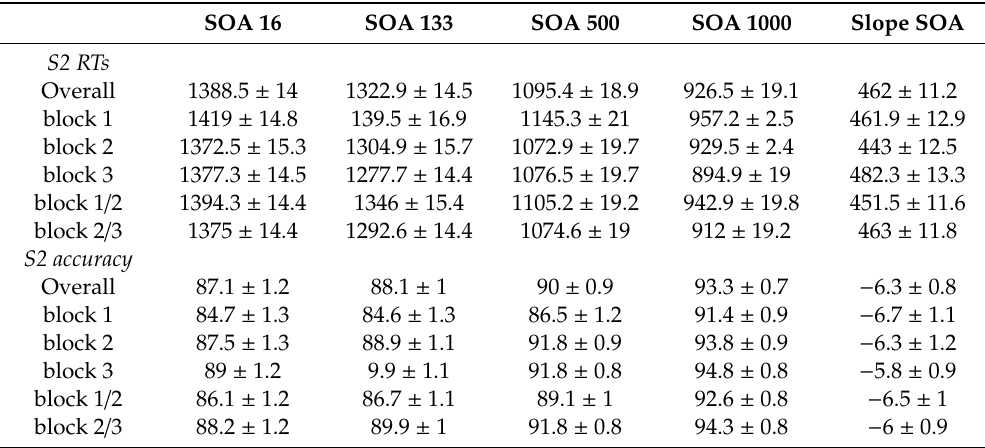
Table 2. Mean RTs, accuracy rates, slope RT and slope Accuracy ( ± standard error of the mean, SEM) of the letter stimulus (S2) for each stimulus-onset asynchrony (SOA)